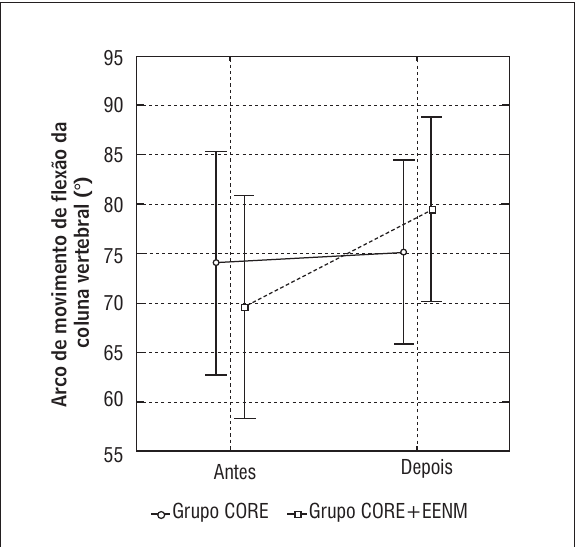
Figura 2 - Valores médios de ADM de flexão da coluna vertebral antes e depois das intervenções Legenda: As barras representam 95% do intervalo de con fi ança. Fonte: Dados da